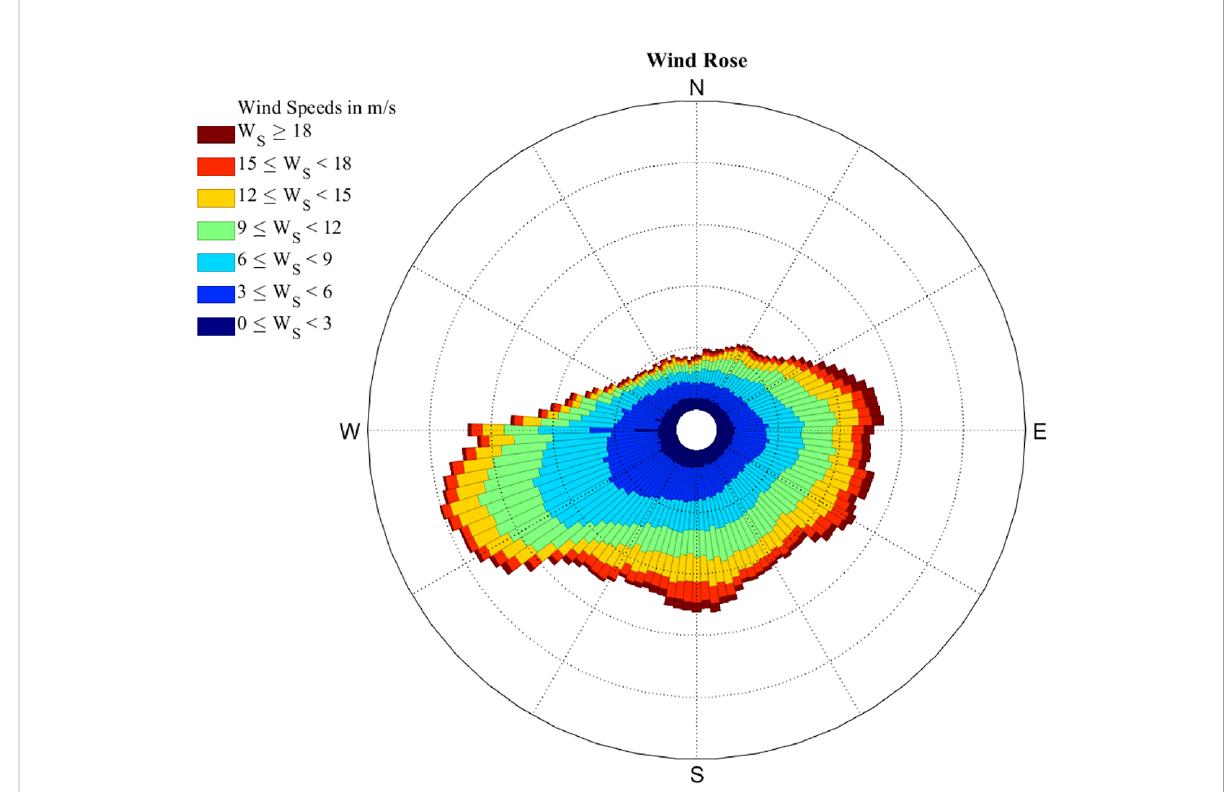
FIGURE 12 Wind rose used to present wind climatology at the Gulf of